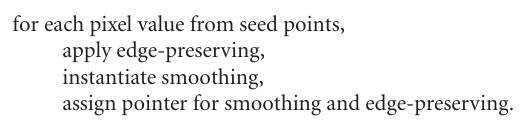
Algorithm 3: Algorithmic representation of region growing